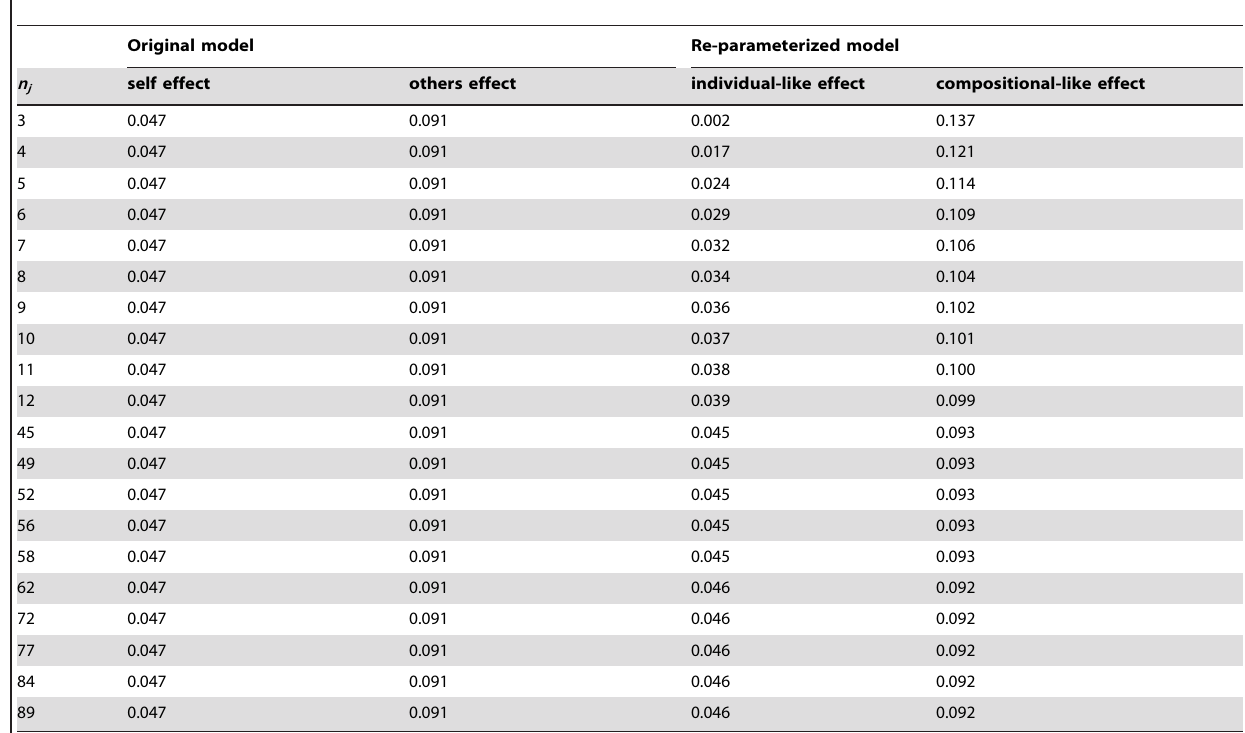
Table 7. Numerical outputs of self-excluded model and its re-parameterized form (as functions of the work unit size n j ).